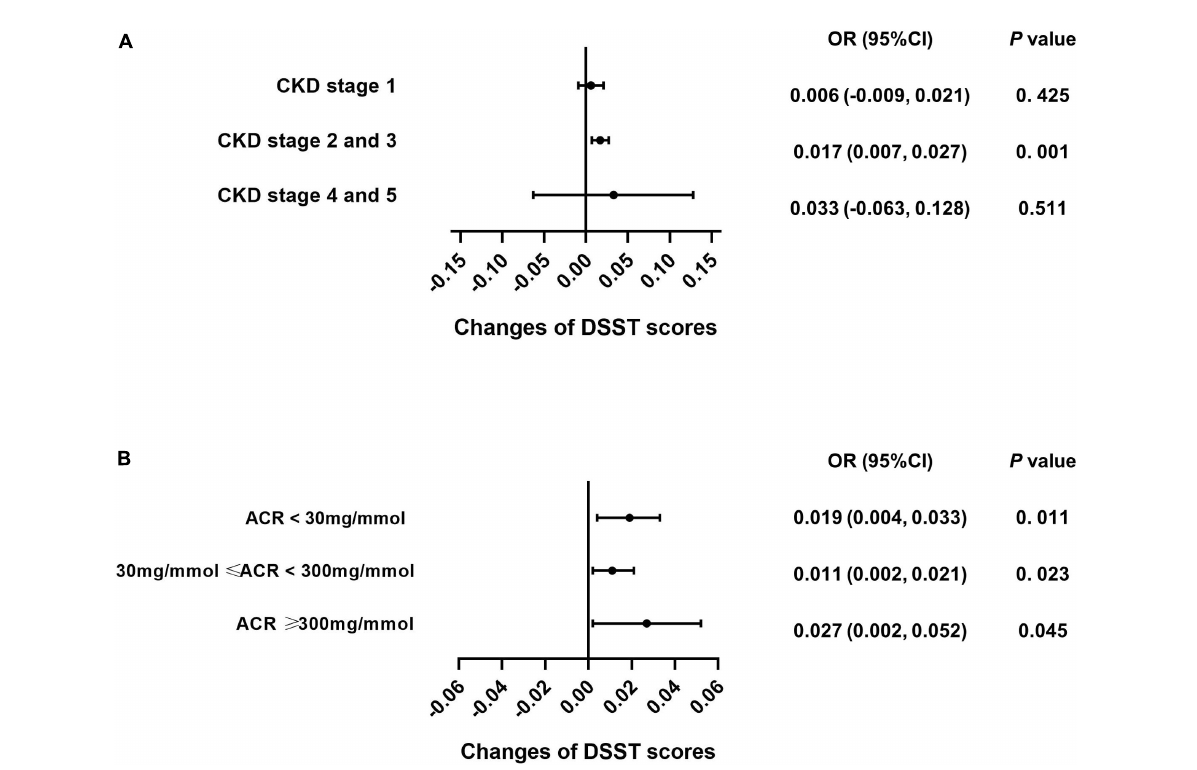
FIGURE6 Caffeine improves scores on the Digit Symbol Substitution Test (DSST) for all CKD stages and ACR levels. We used logistic regression analysis to investigate whether caffeine intake would affect the DSST scores in each CKD subgroup (CKD stage 1 = 59 subjects, CKD stage 2 and 3 = 362 subjects, CKD stage 4 and 5 = 21 subjects) and urinary albumin creatinine ratio (ACR) subgroup (ACR < 30 mg/mmol = 196 subjects, 30 mg/mmol ≤ ACR < 300 mg/mmol = 210 subjects, ACR ≥ 300 mg/mmol = 36 subjects). Caffeine intake improved the performance of patients on the DSST with CKD stages 2 and 3 only (OR = 0.017, 95% CI: 0.007–0.027, P < 0.001, A ). Caffeine benefited DSST for all ACR groups (ACR < 30 mg/mmol, OR = 0.019, 95% CI: 0.004–0.033, P = 0.011; 30 mg/mmol ≤ ACR < 300 mg/mmol, OR = 0.011, 95% CI: 0.002–0.021, P = 0.023; ACR ≥ 300 mg/mmol, OR = 0.027, 95% CI: 0.002–0.052, P = 0.045, B